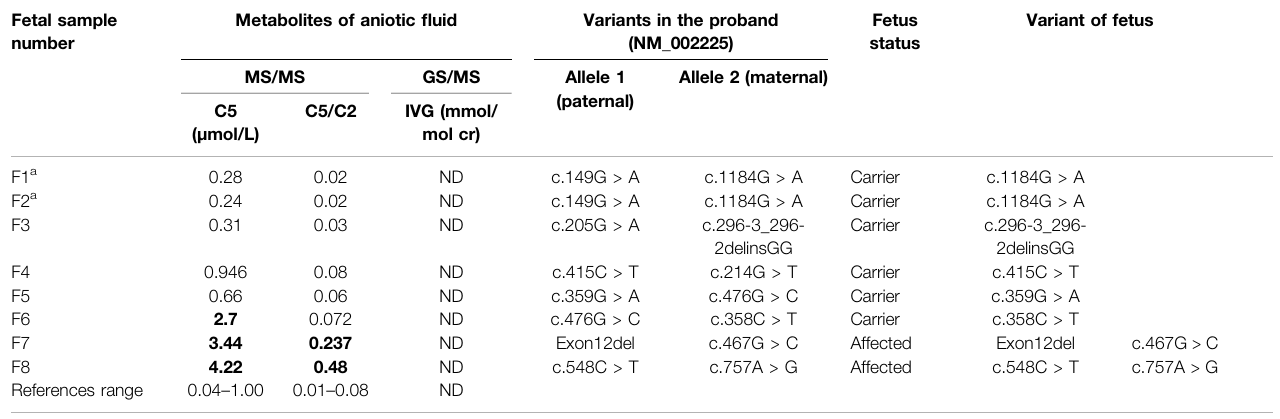
TABLE 1 | The prenatal results of biochemical and genetic tests analysis in the amniotic fl uid samples of eight fetuses. Fetal sample number